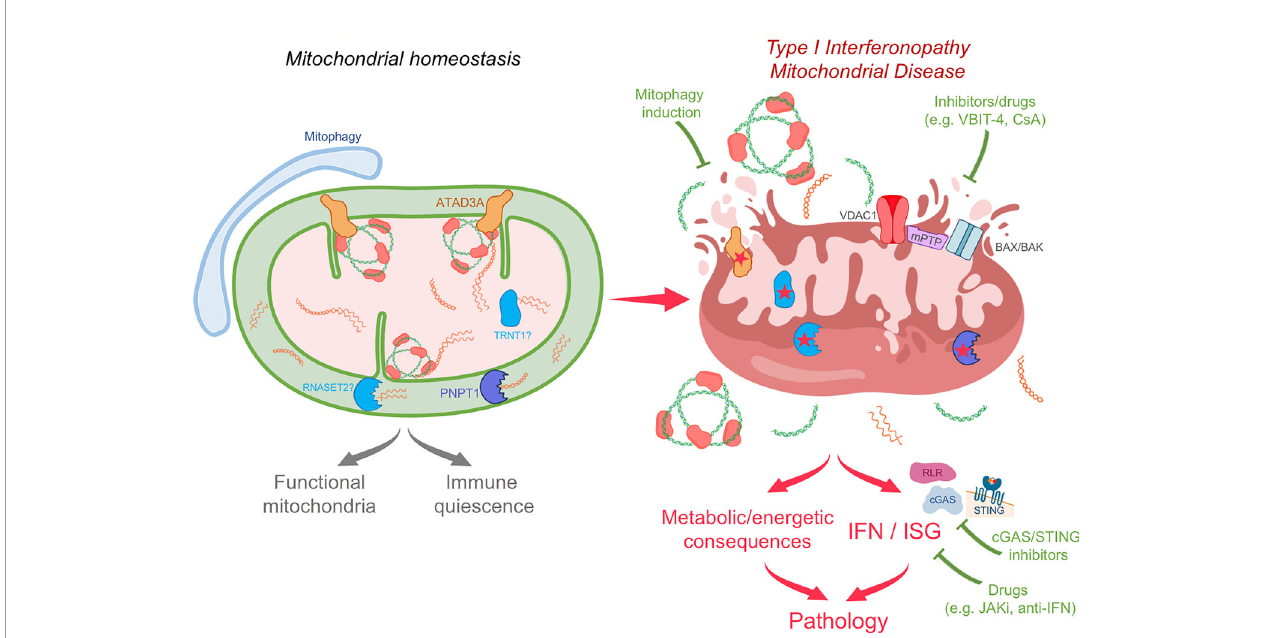
FIGURE 2 | Potentially common pathogenic mechanisms in type I interferonopathy and mitochondrial disease and therapeutic perspectives. Due to the immunostimulatory potential of mtNA, active processes are required to ensure mitochondrial homeostasis and immunological quiescence. These include degradation of mtdsRNA by PNPT1, maintenance of mtDNA and mitochondrial structure by molecules such as ATAD3A, and metabolism of mtRNA by proteins such as RNASET2 and TRNT1. More general mitochondrial quality control mechanisms are involved as well, including mitophagy and mitochondrial proteases. Defects in these processes may result in both mitochondrial disease and a type I interferonopathy state. Indeed, loss of function of PNPT1 and ATAD3A, and possibly of RNASET2 and TRNT1, can lead to mitochondrial stress and mtNA cytosolic leakage and sensing. In the type I interferonopathies linked to mutations in PNPT1 and ATAD3A, in addition to mitochondrial dysfunction, there is chronic induction of IFN and ISGs. This might also be a feature of other mitochondrial diseases, which may have gone undetected due to lack of relevant investigations. Identifying immunostimulatory mtNA and IFN induction as pathogenic mechanisms opens new therapeutic perspectives, including by inhibition of type I IFN signaling (JAK inhibitors (JAKi), anti-IFN system antibodies), mtNA sensing (cGAS/STING inhibitors), mitochondrial membrane opening [VBIT-4, cyclosporin A (CsA)], or by mitophagy